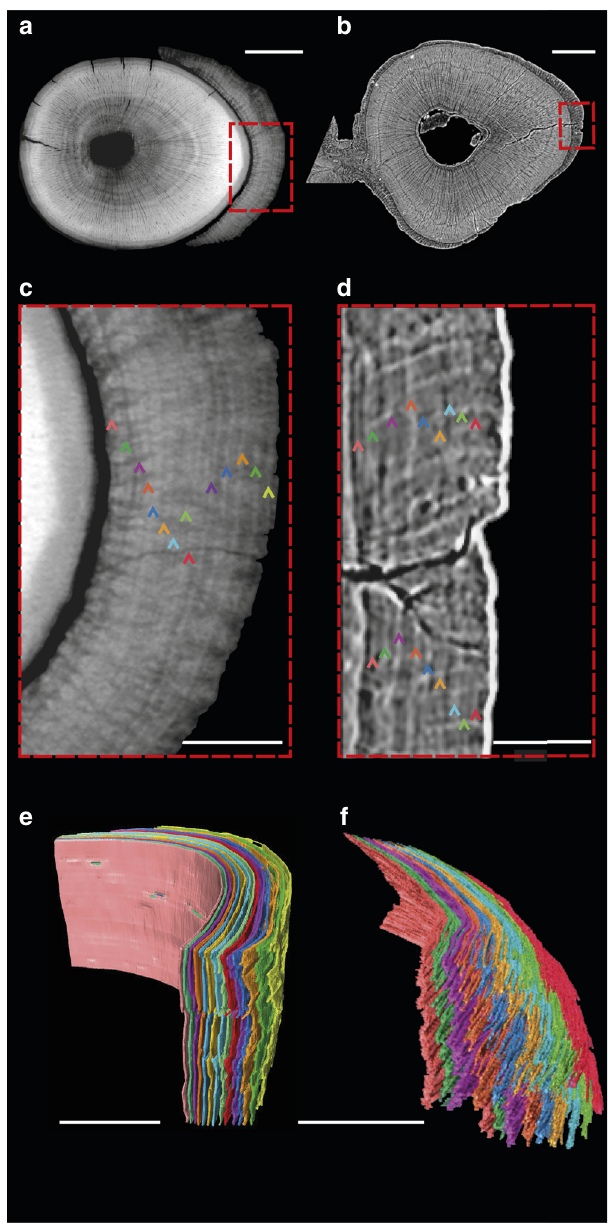
Fig. 3 Three-dimensional segmentation of Morganucodon and Kuehneotherium specimens with the highest counts of cementum increments. a , b Transverse virtual thin sections of PPC-SR µ CT reconstructions (0.33 μ m 3 voxel size). a Morganucodon specimen NHMUK PV M 104127 showing a 55- μ m-thick layer of cementum around the root dentine. b Kuehneotherium specimen UMZC Sy 141 showing a 32- μ m-thick layer of cementum. c , d Detail of the cementum of c NHMUK PV M 104127 and d UMZC Sy 141. Cementum increments highlighted by 14 and 9 multi-coloured arrows, respectively. e , f 3D segmentations of the cementum increments of e NHMUK PV M 104127 and f UMZC Sy 141. The colour of each increment corresponds to the colours of each arrow in c , d , respectively. Scale bars represent 100 µ m in a , b , 30 µ m in c , d and 30 µ m in e , f .